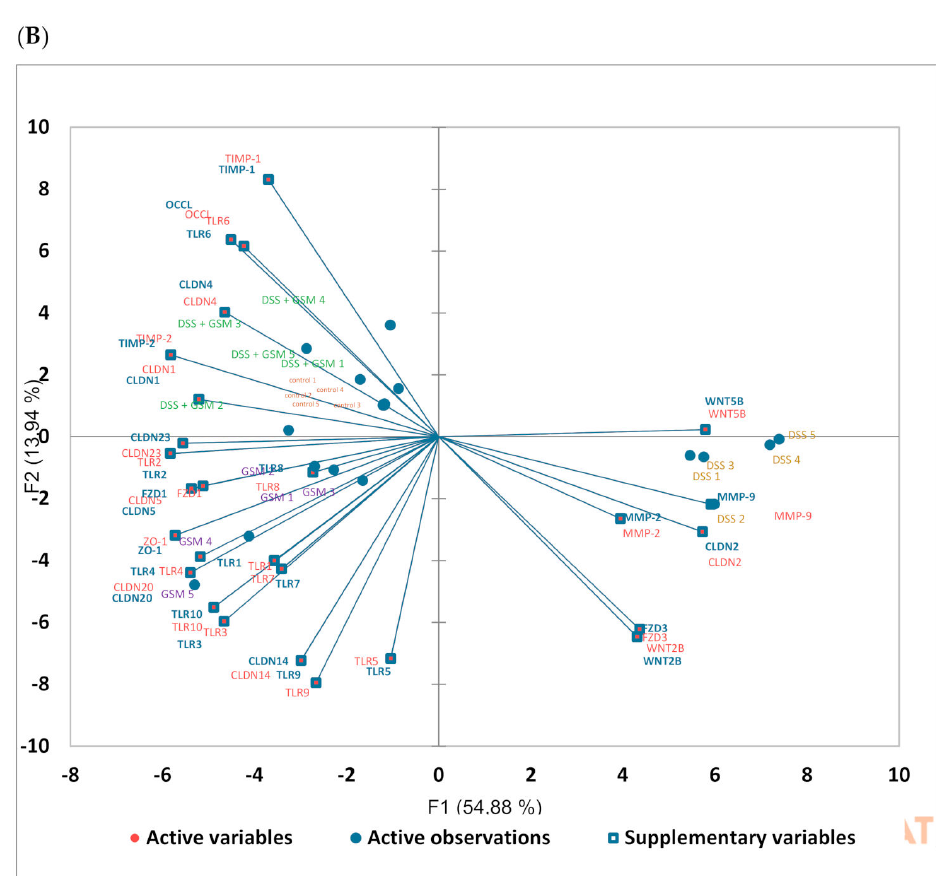
Figure 7. Principal component analysis (PCA) plots experimental groups with 27 genes based on qPCR data set. ( A ). The score plot differentiates the four experimental groups by two-dimensional expression clustering. Each point represents one sample; the color indicated sample groups, as follows: black color—Control group, blue color—DSS group, red color—GSM group and orange color—DSS + GSM group. ( B ). The loading plot with differentially expressed genes in relation to the largest portion of the variance among experimental